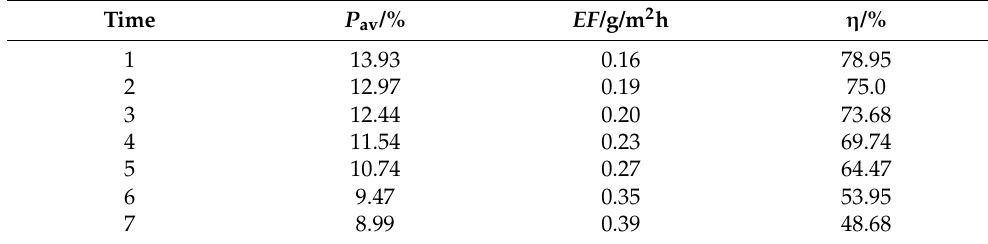
Table 3. PM 10 emission factors and dust suppression efficiency during continuous use.